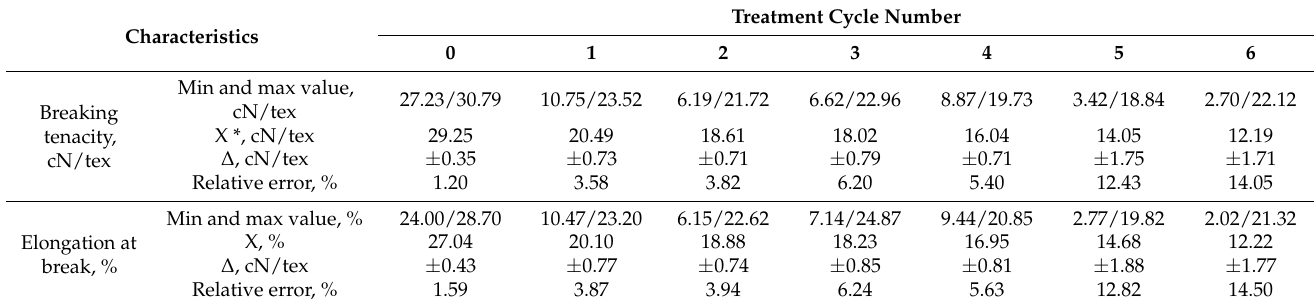
Table 1. Tensile characteristics of investigated PA6 fibers.